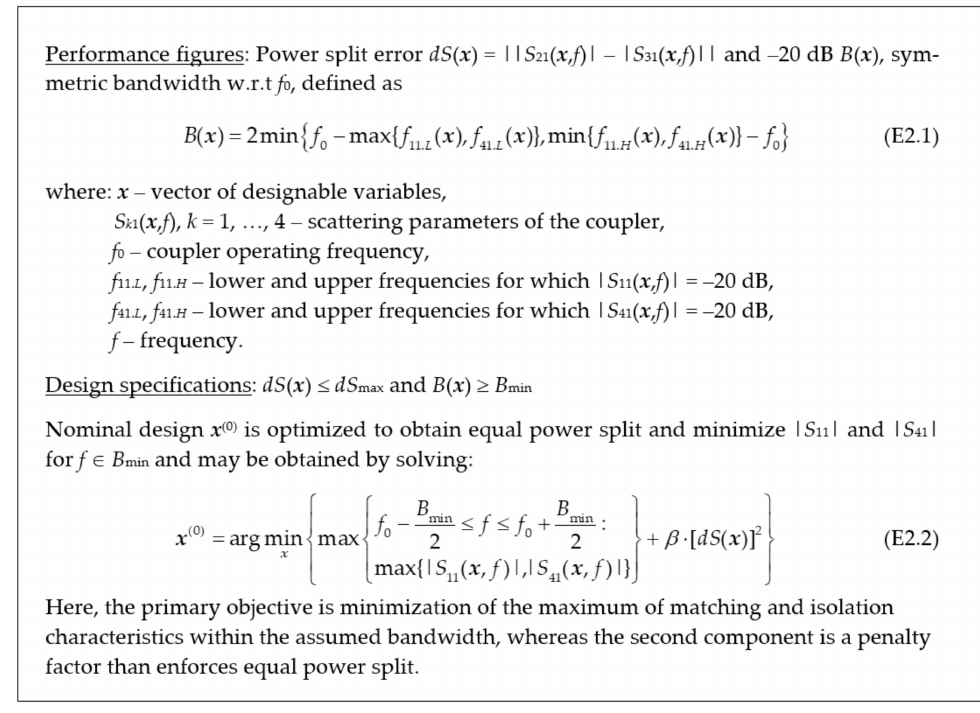
Figure 2. Example II: Microwave coupler optimized to ensure the target power split and bandwidth